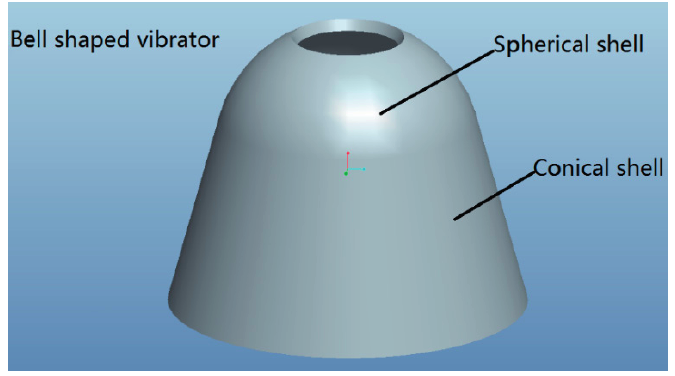
Figure 1. Axisymmetric multi-curved surface shell